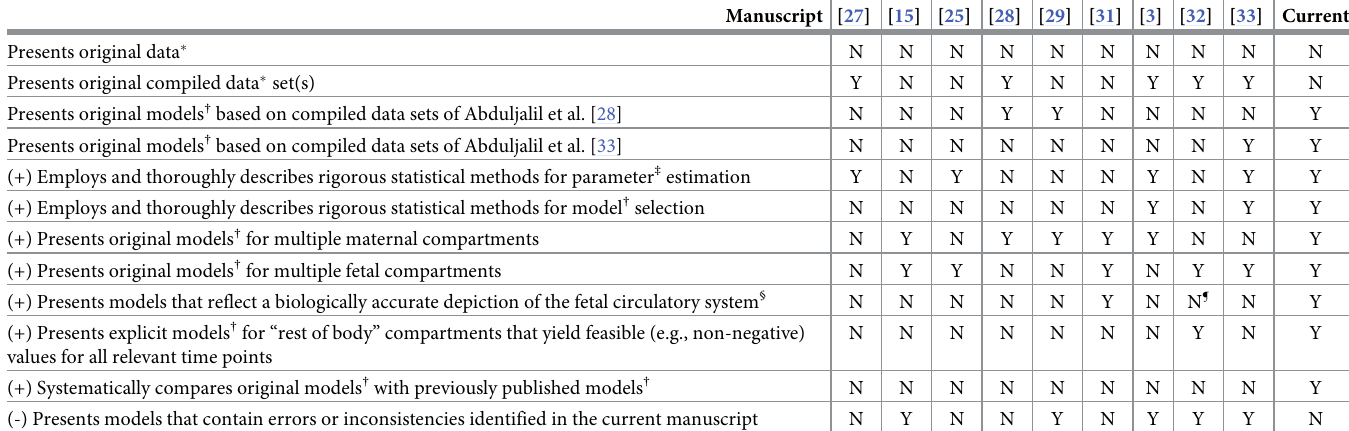
Table 1. Itemized comparison of selected publications that contain one or more formulae related to human gestation and